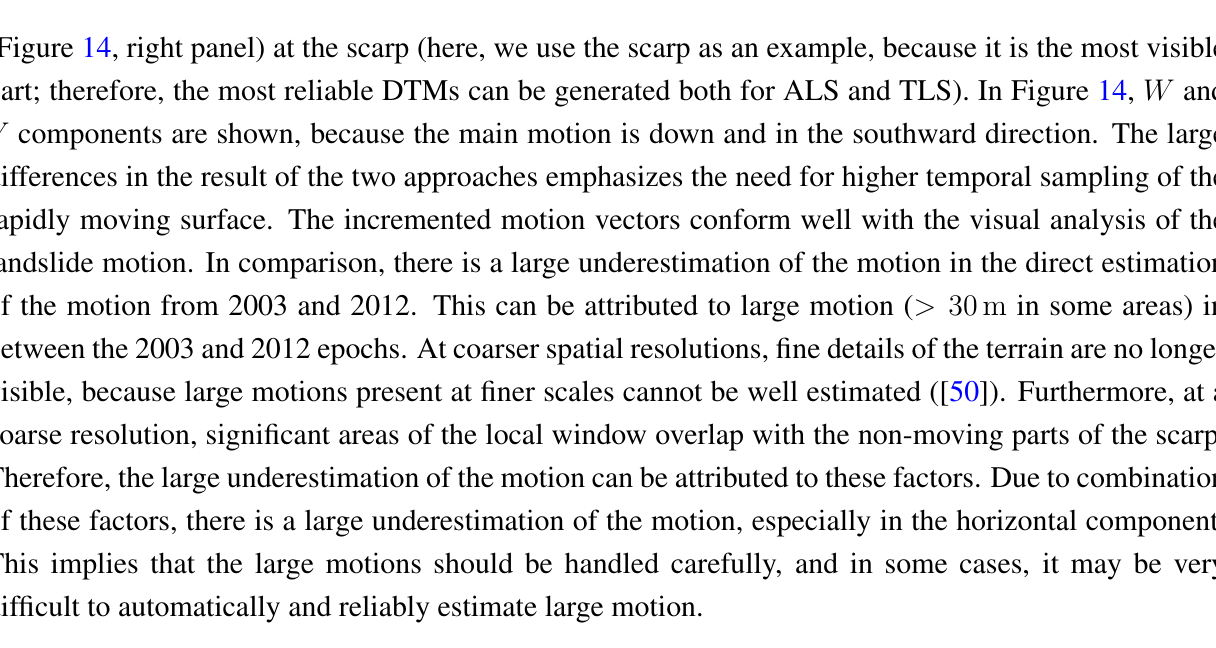
Figure 14. ( Left ) Incremental flow W and V component from 2003 to 2012 (including all measured epochs); ( Middle ) direct estimated W and V from 2003–2012; ( Right ) difference between the incremental and direct estimated W and V at the